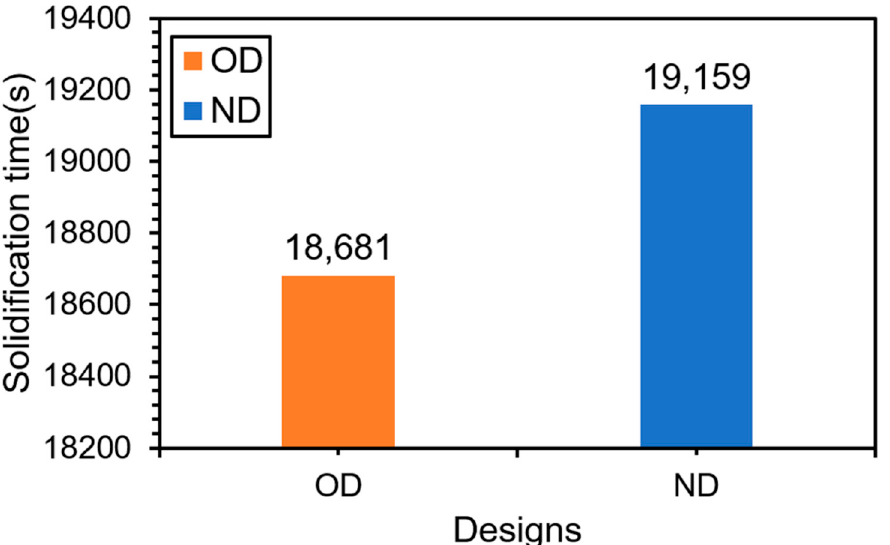
Figure 7. Solidification time at the end of solidification in OD and ND.